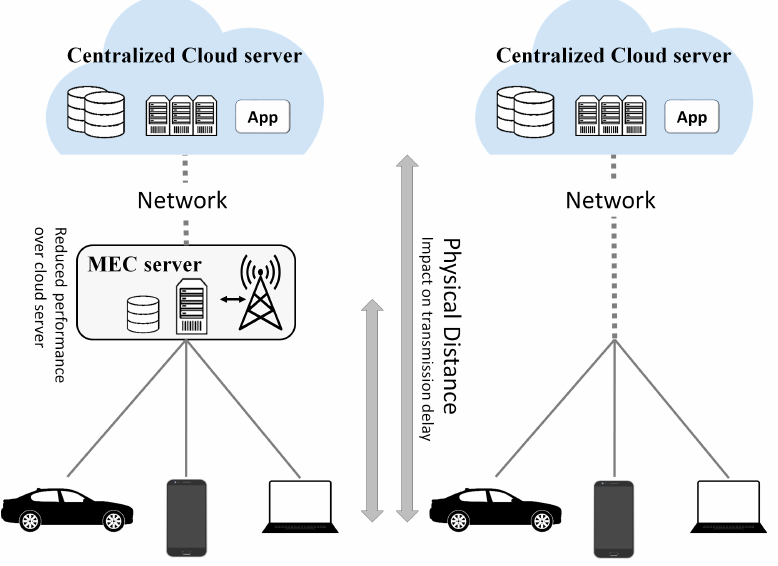
Figure 1. Edge computing and cloud computing